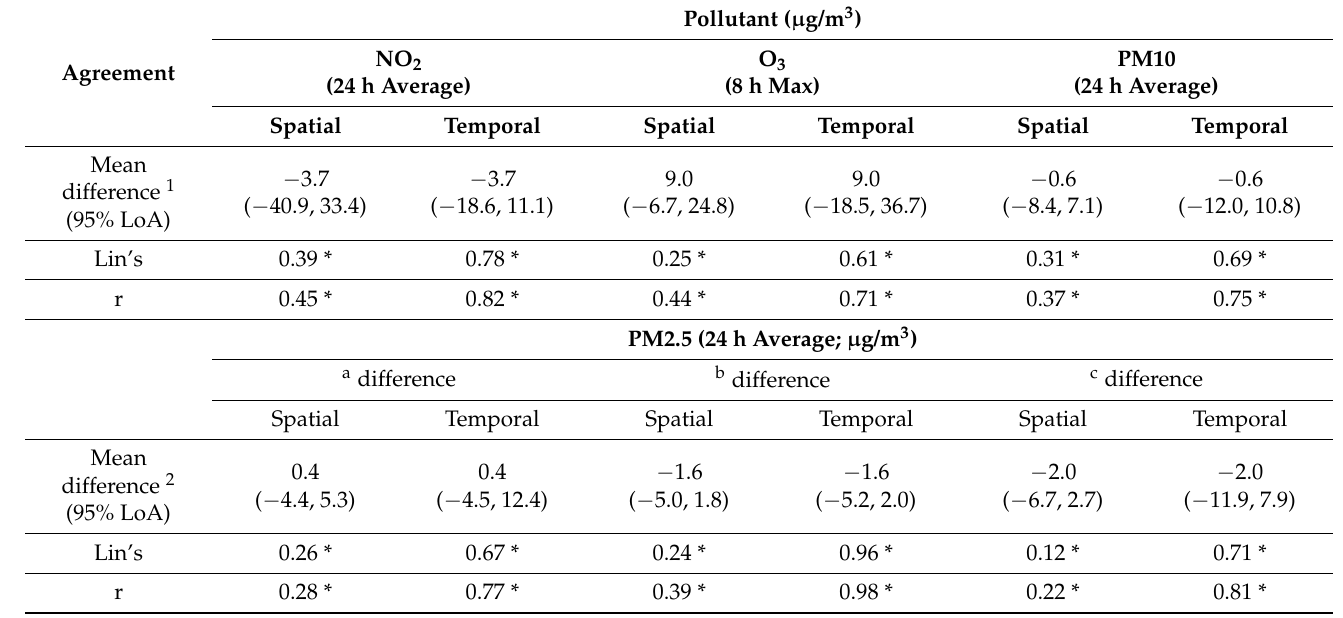
Table 2. Summary of agreement between the independent exposure assessment